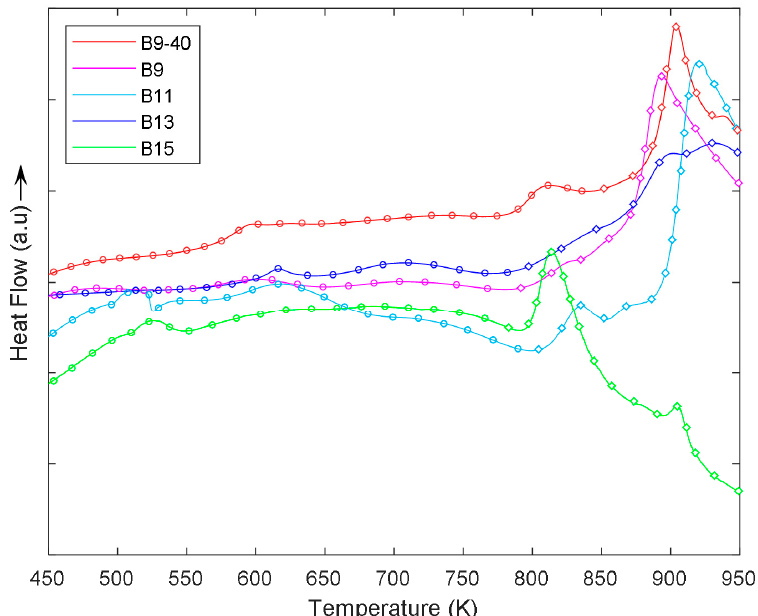
Figure 6. DSC curves for samples B9-40, B9, B11, B13, and B15 to observe both the effects of milling time and B doping. The scan points marked with ο correspond to structural relaxations while areas with ◊ correspond to crystal growth.